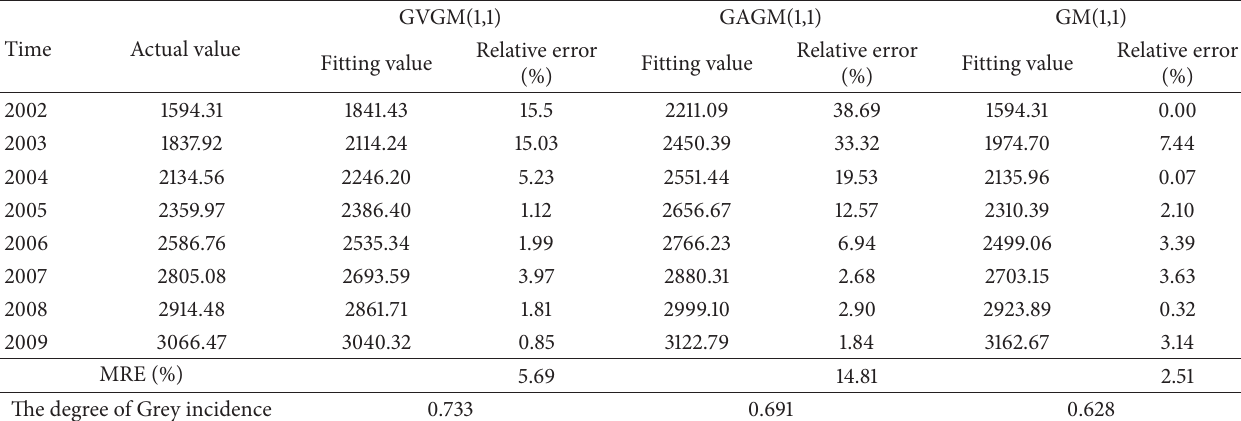
Table 1: In-sample comparisons among the GVGM, GAGM, and GM models.